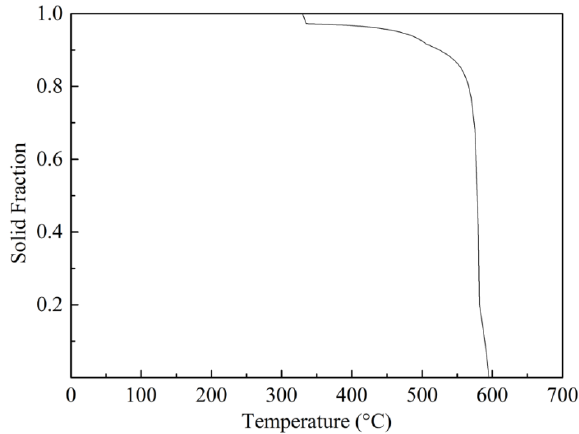
Figure 4. Solid fraction curve versus temperature of the Mg–10Zn–6.8Gd–4Y alloy.